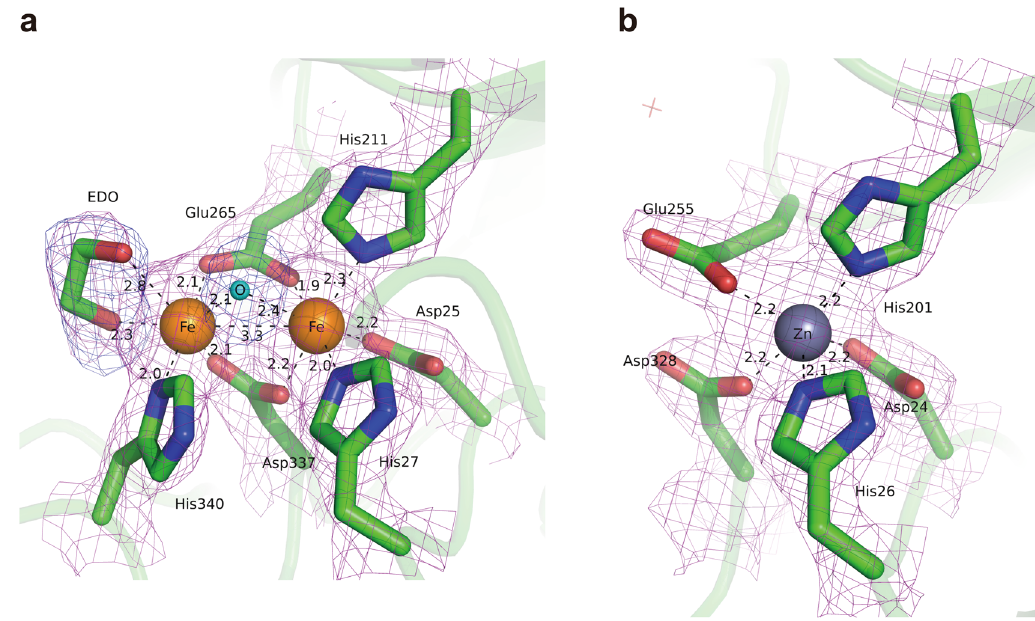
Fig. 5 Overview of the metal-binding sites in AibH1H2 complex. The (2 F o − F c ) OMIT electron-density map (magenta mesh) contoured at 1.4 σ is superimposed on the re fi ned model. a AibH2 subunit bound to two Fe ions. Fe ions are shown as orange spheres and coordinated by six AibH2 residues (shown as the green sticks), O atom (cyan sphere), and EDO. The ( F o − F c ) OMIT electron-density map (blue mesh) contoured at 3.0 σ is also superimposed. b AibH1 bound to a Zn ion. Zn ion is shown as a gray sphere and coordinated by fi ve AibH1 residues (shown as the green sticks). Black dashes indicate metal coordination and selected hydrogen